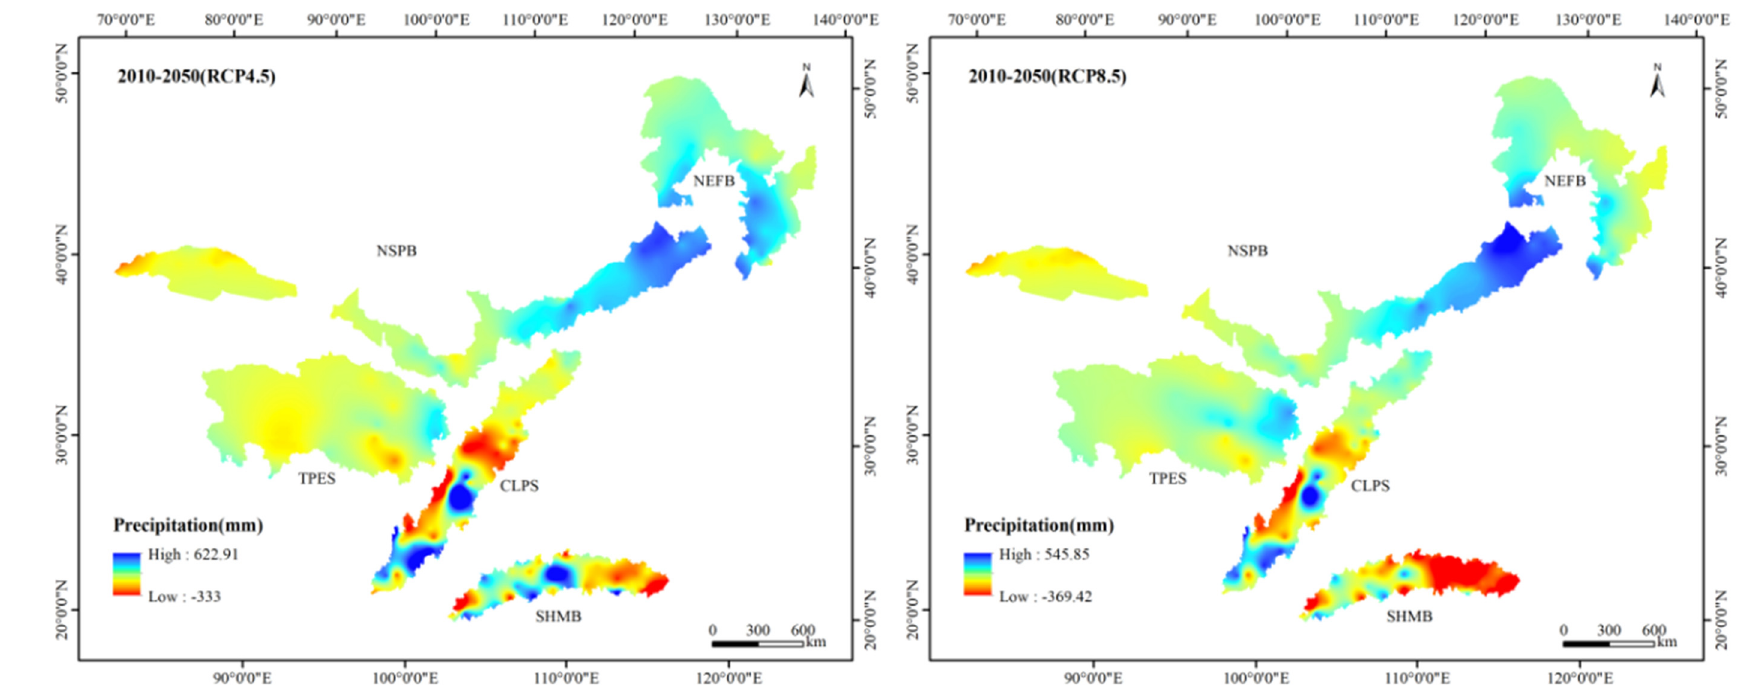
ff erence between 2010 and 2015 of precipitation in the Figure 7. Spatial difference between 2010 and 2015 of precipitation in the TSTB. Figure 7. Spatial di